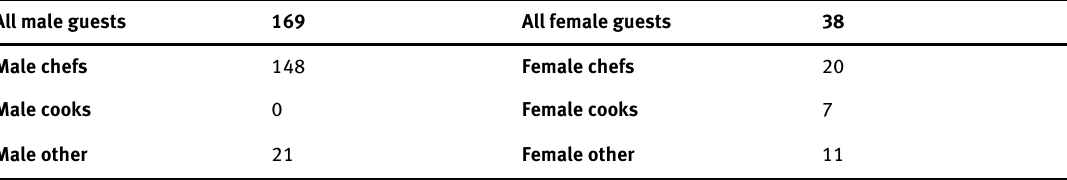
Table 3: Total numbers of celebrity guests by category, seasons 1-7 All male